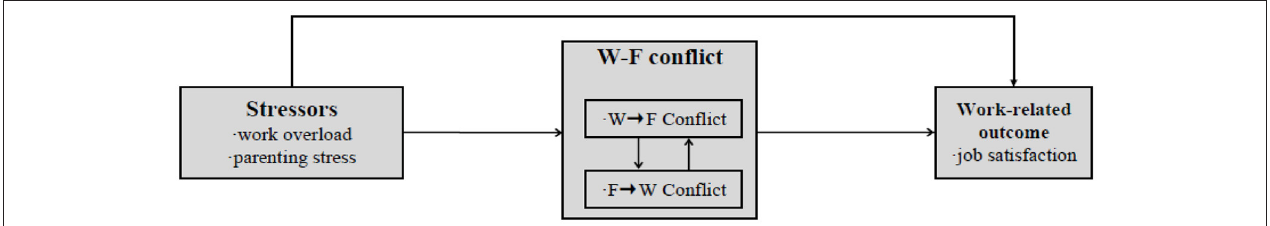
FIGURE 1 | Model of stressors, work-family conflict and